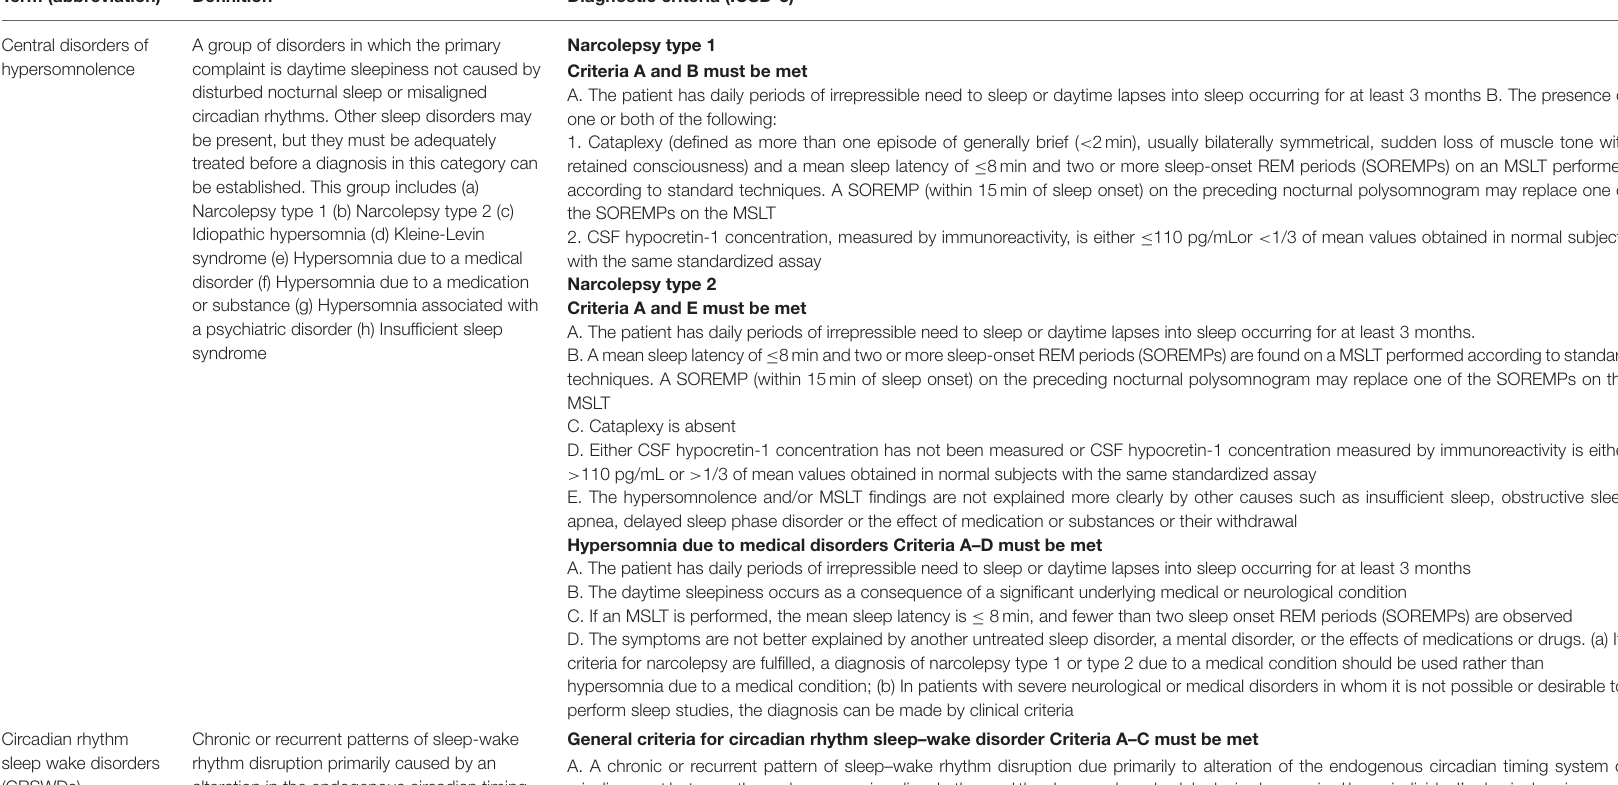
TABLE 5 | Classification and definition of sleep disorders of interest in patients with craniopharyngioma